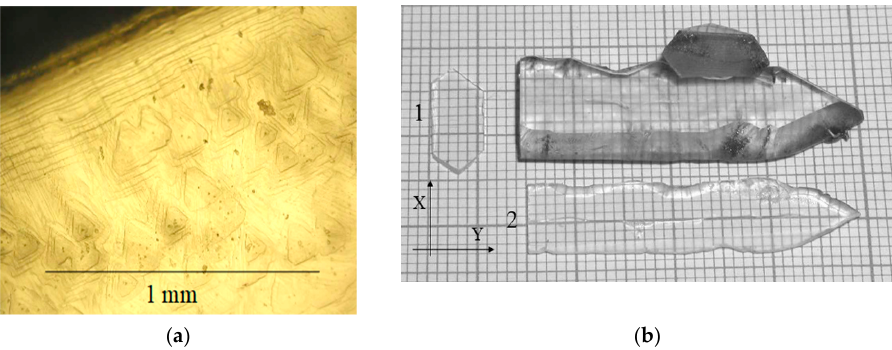
Figure 4. ( a ) Face of basal pinacoid c{0001} is represented by layer ‐ dislocation growth mechanism, at gradients up to 15 °C; ( b ) GaPO 4 crystal grown on ZY seed plate and plates cut from this crystal: 1— cut perpendicular to Y axis, 2—perpendicular to Z axis.